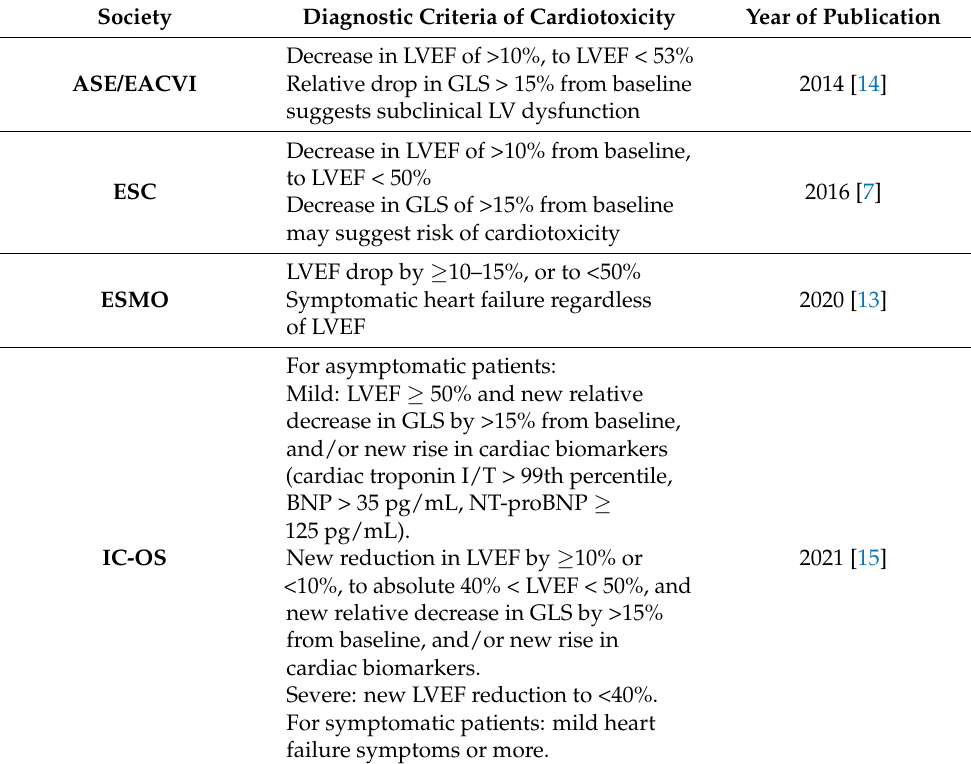
Table 1. Diagnostic criteria for